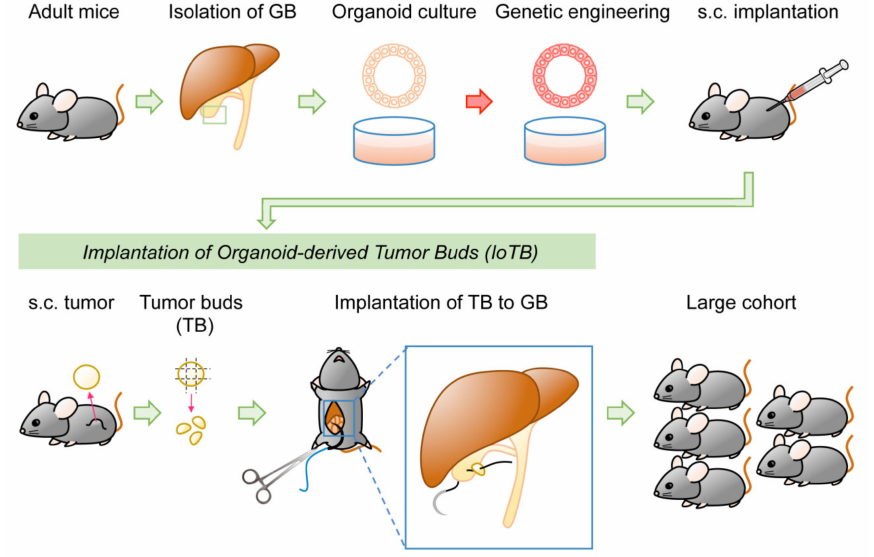
Figure 5. The two-step implantation model of GBC. Genetically engineered organoids were inocu- lated into the subcutis of syngeneic mice. In the second step, the IoTB approach facilitated accurate preclinical studies in a large